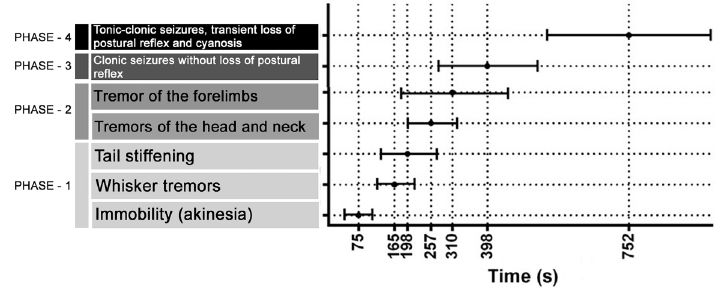
Figure 1. Description of seizure-related behavior induced by thiocolchicoside and latency